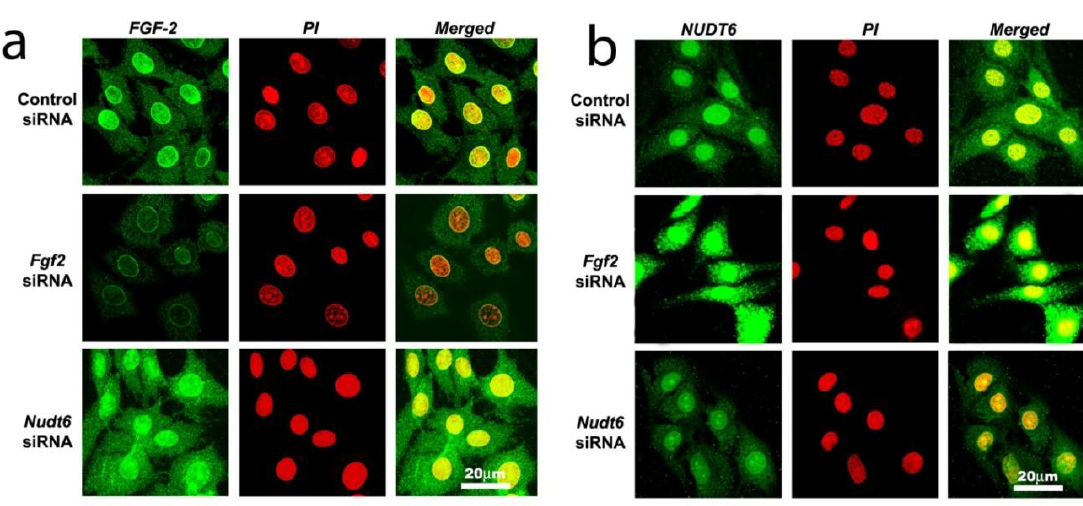
Figure 4. Confocal immunofluorescence detection of FGF2 protein (green in Panel a ) and NUDT6 (green in Panel b ) in C6 glioma cells 72 hours after transfection with100 nM of a control negative scramble sequence, FGF 2 siRNA or NUDT6 siRNA. Red indicates propidium iodide (PI) staining of cell